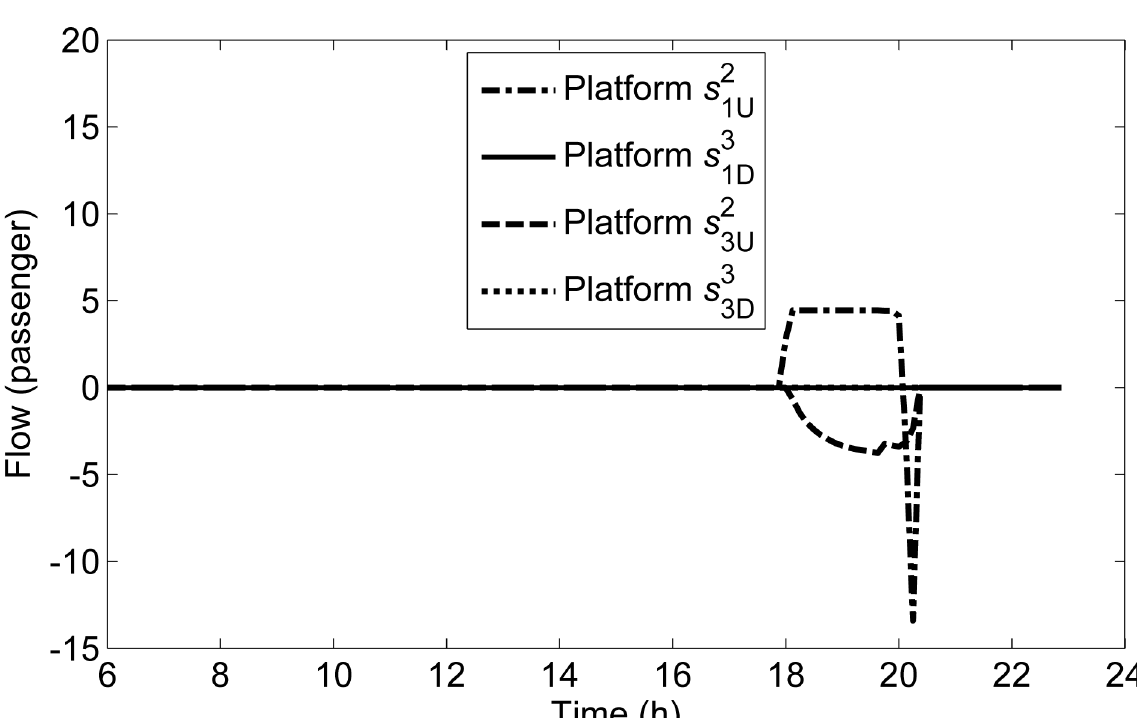
Fig 12. Transmitted and passing flows on s 2